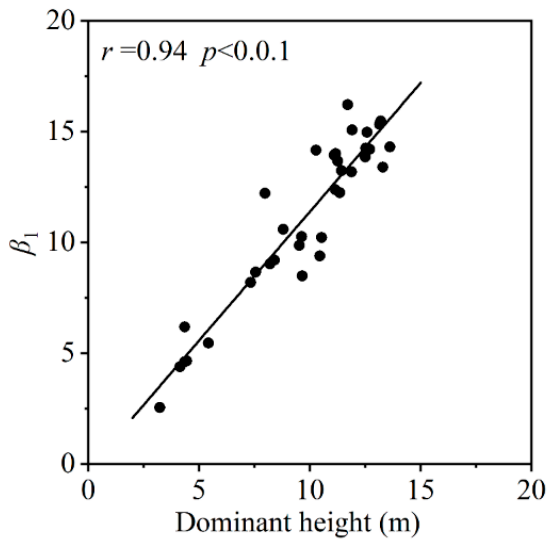
Figure 3. Linear relationship between the dominant height (DH) and the estimated coefficient β 1 of the basic model. R means the Pearson correlation between the model coefficient β 1 of the basic model and dominant height.